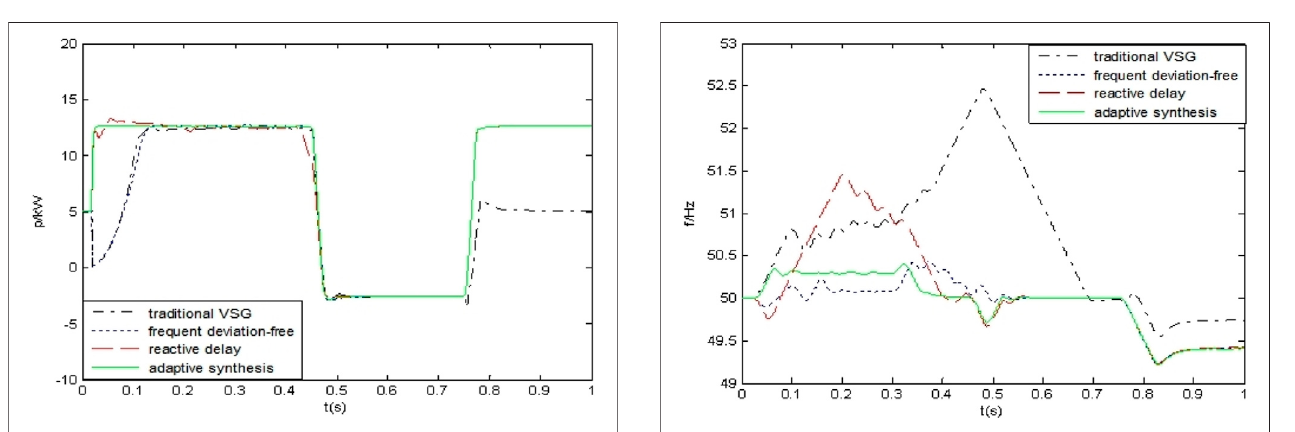
FIGURE 9 | Frequency variation of the